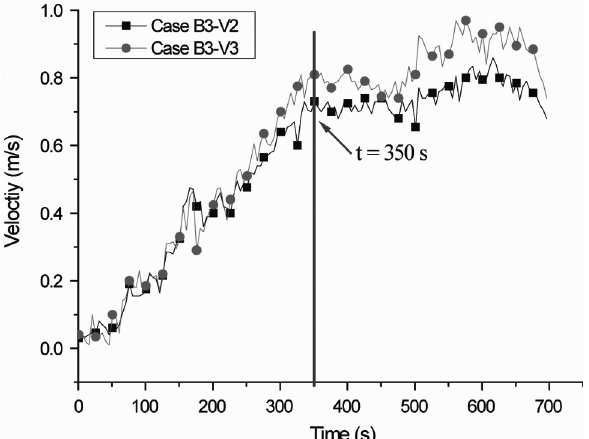
Fig. 4. Velocity of airflow into fire room of Case B3 (Pool: